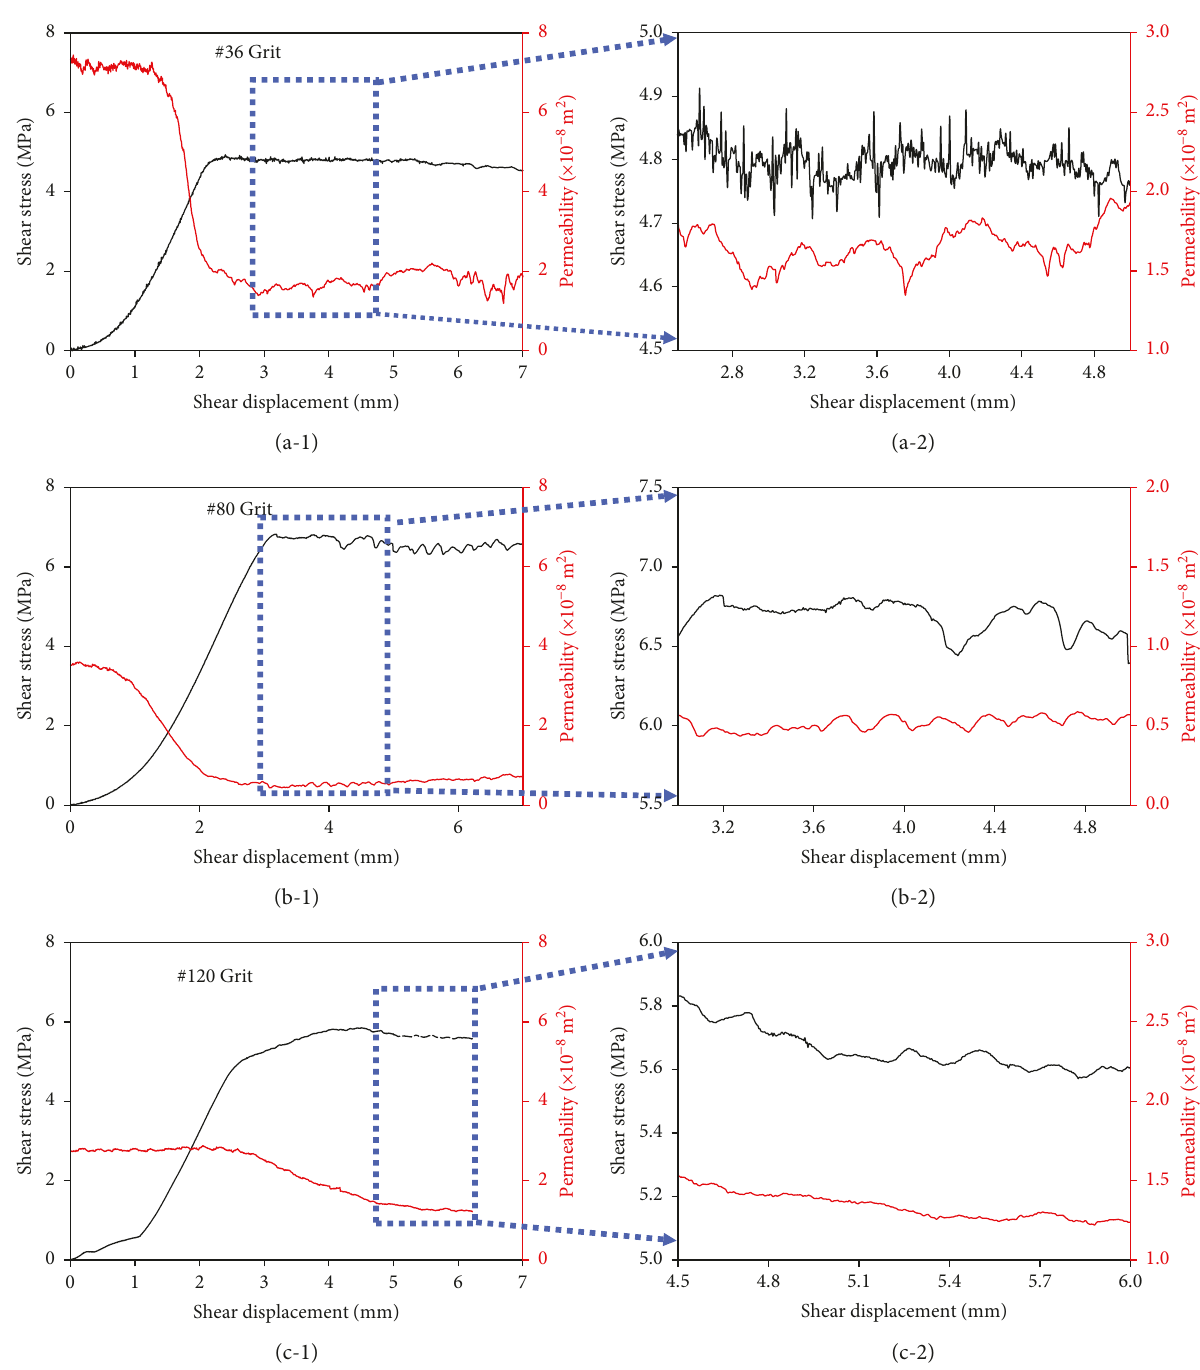
Figure 4: Shear-induced permeability evolution of sandstone fractures: (a-1) shear response and permeability evolution of #36 Grit fracture; (a-2) shear response and permeability evolution of #36 Grit fracture during stable shear stage; (b-1) shear response and permeability evolution of #80 Grit fracture; (b-2) shear response and permeability evolution of #80 Grit fracture during stable shear stage; (c-1) shear response and permeability evolution of #120 Grit fracture; (c-2) shear response and permeability evolution of #120 Grit fracture during stable shear